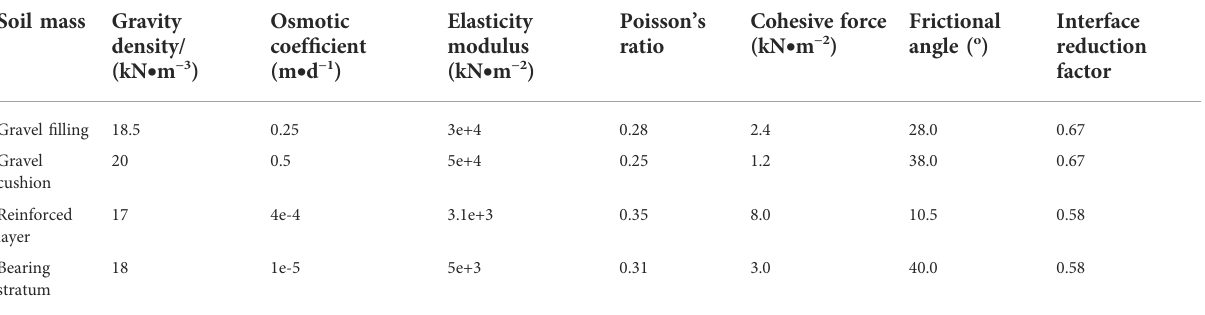
TABLE. 2 Parameters of the soil mass.